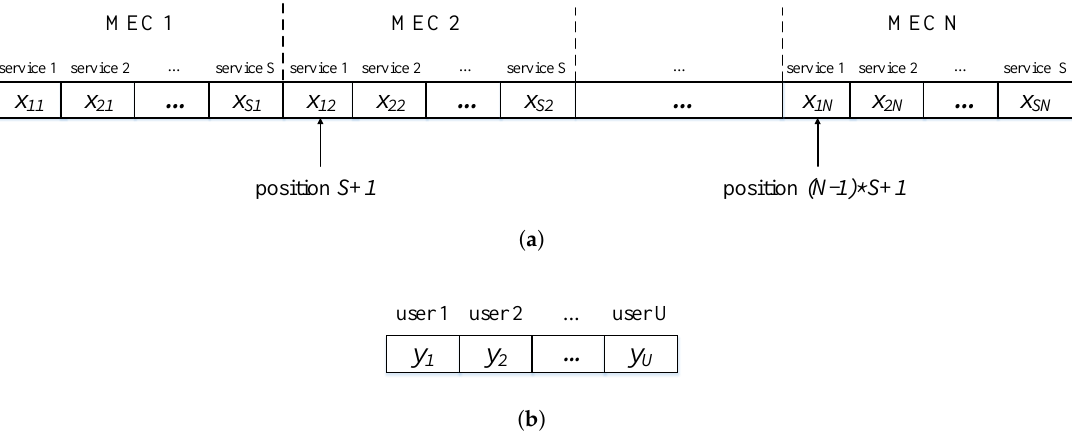
Figure 4. Chromosome representation. ( a ) Service placement individual x = { x sn ∈ { 0,1 }| s ∈ S , n ∈ N} ; ( b ) Request scheduling individual y = { y u ∈ H u | u ∈ U} , H u = { 0 } ∪ { n ∈ N| x s